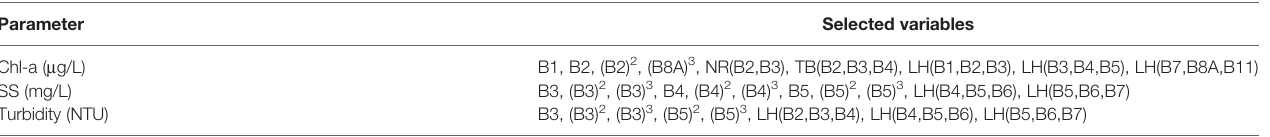
TABLE 5 | The variables selected as inputs in the ANN models developed in this study for chlorophyll-a (Chl-a), suspended solids (SS) and turbidity. Parameter Selected variables Chl-a ( m g/L) Turbidity (NTU) B1 – B12 refer to spectral re fl ectance of bands 1 – 12. NR(B2,B3) refers to the normalized ratio of band 2 and band 3, computed according to Equation 1. TB(B2,B3,B4) refers to the three-band ratio of band 2, band 3 and band 4, computed according to Equation 2. LH(B1,B2,B3) refers to the line-height variable using band 1, band 2 and band 3, computed according to Equation